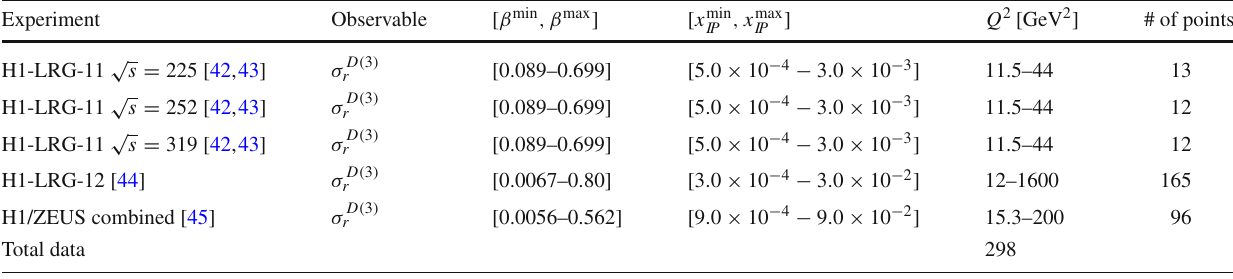
Table 1 List of all diffractive DIS data points used in Fit A global analysis. For each dataset we have provided the references, the kinematical coverage of β , x IP , and Q 2 and the number of data points. The details of kinematic cuts explained in the text Experiment